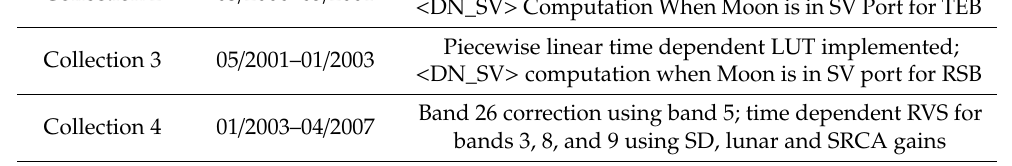
SNR or NEdT Spec.